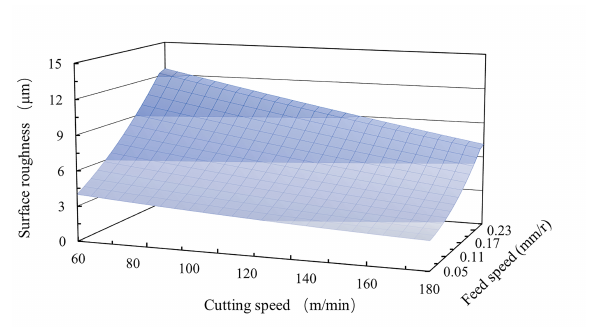
Fig. 10. Results of hole surface